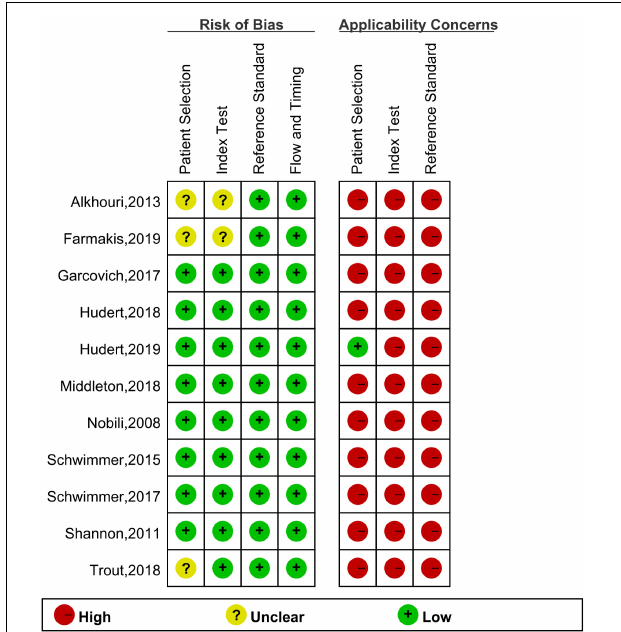
FIGURE 2 | Quality assessment per